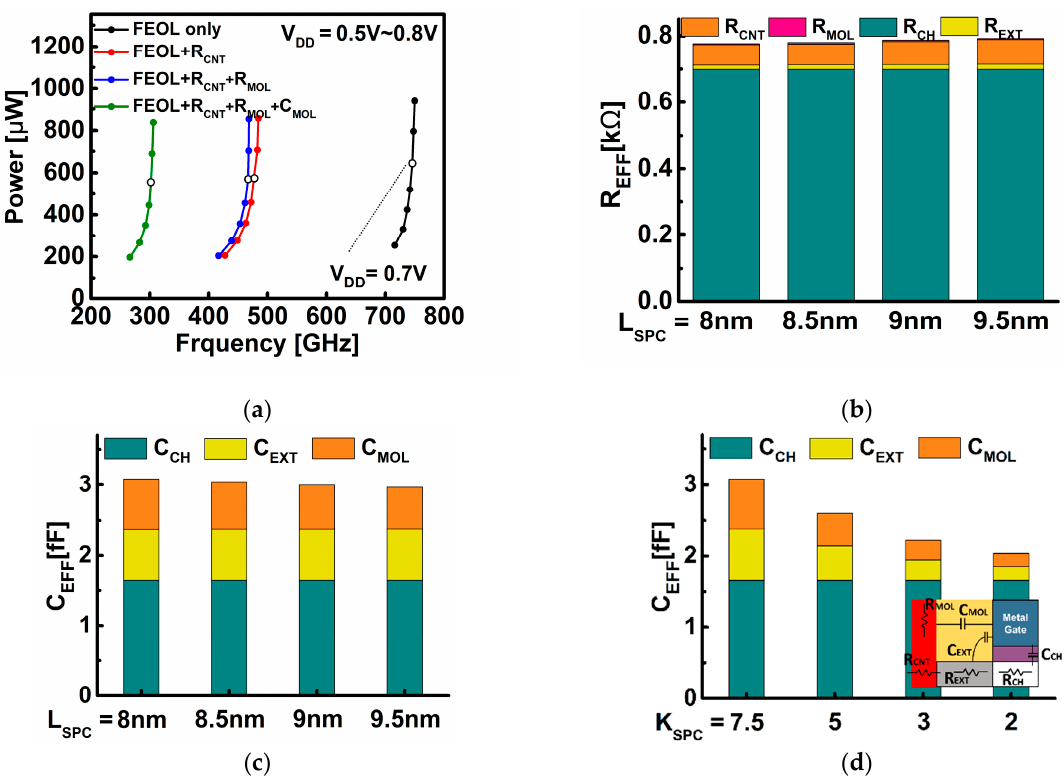
Figure 5. ( a ) Circuit power performance (power consumption, operating frequency) when contact resistance and MOL components are added to the intrinsic channel; ( b ) analysis of results of the effect of various components on circuit using R EFF ; ( c ) analysis of results of the effect of various components on circuit according to L SPC using C EFF ; ( d ) analysis of results of the effect of various components on circuit according to K SPC using C EFF . The figure inserted in ( d ) shows resistances for channel (R CH ), extension (R EXT ), contact (R CNT ), and MOL (R MOL ) and capacitances for channel (C CH ), extension (C EXT ), and MOL (C MOL ), respectively.